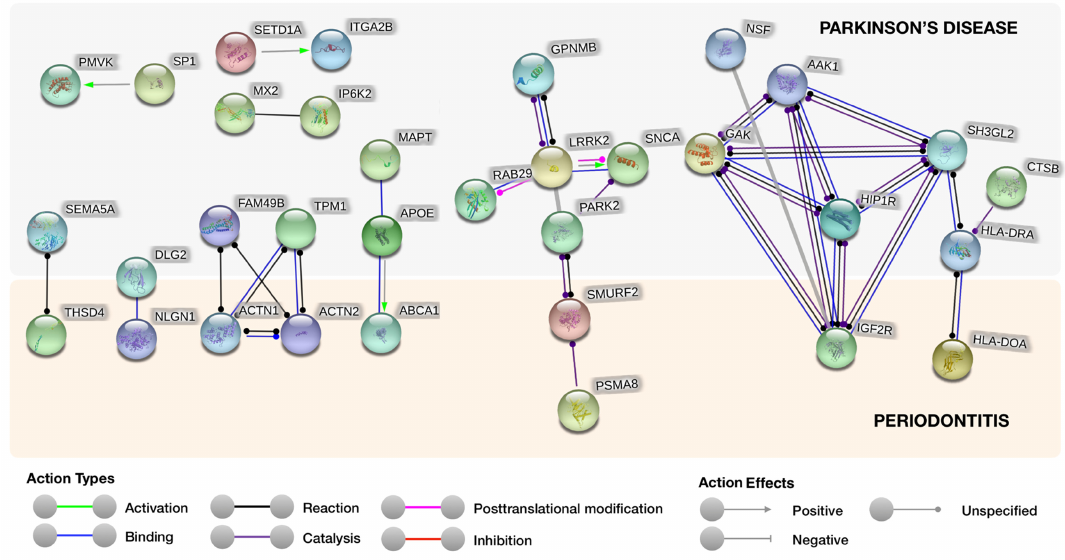
Figure 1. Search Tool for the Retrieval of Interacting Genes/Proteins (STRING) analysis reveals protein interaction networks between Parkinson’s disease and periodontitis proteins. We implemented the highest confidence cutoff of 0.9 in this network. In the resulting protein association network, proteins are presented as nodes which are connected by lines whose thickness represents the confidence level (0.9).